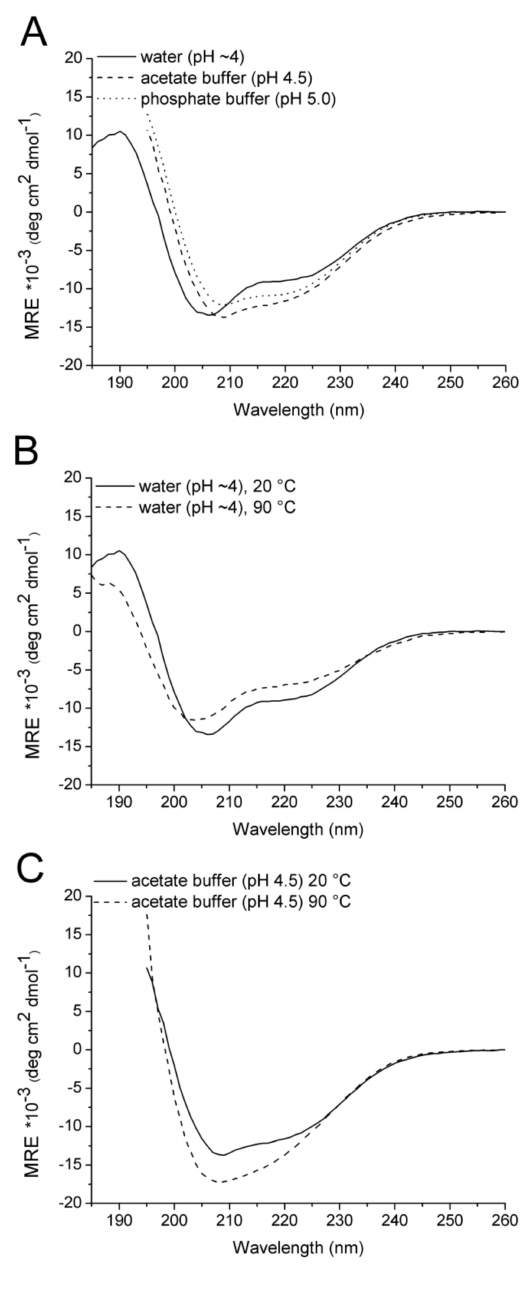
Figure 1. Circular dichroism (CD) spectra of recombinant Id2’ (30 µ M). ( A ) CD curves in 100 mM buffer (pH 4.5 or 5.0) or in pure water (pH~4). ( B ) CD curves in pure water at 20 ◦ C and 90 ◦ C. ( C ) CD curves in sodium acetate buffer at 20 ◦ C and 90 ◦ C. The CD spectra of the buffered solutions could be recorded only until 195 nm due to exceeding detector voltage below this wavelength. The CD unit is the molar residue ellipticity (MRE = [ θ ] R ) that was divided by 10 3 for convenience of representation of the